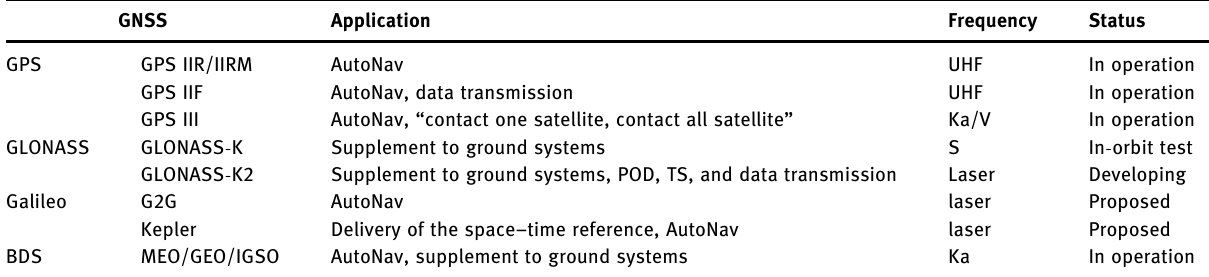
Table 1: Status of GNSS ISLs GNSS Application